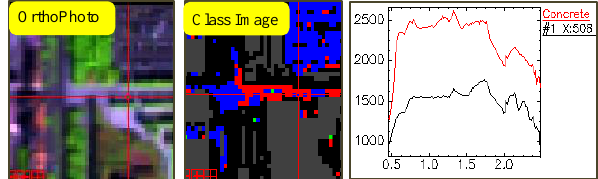
Figure 3. An example of a correctly classified area of concrete